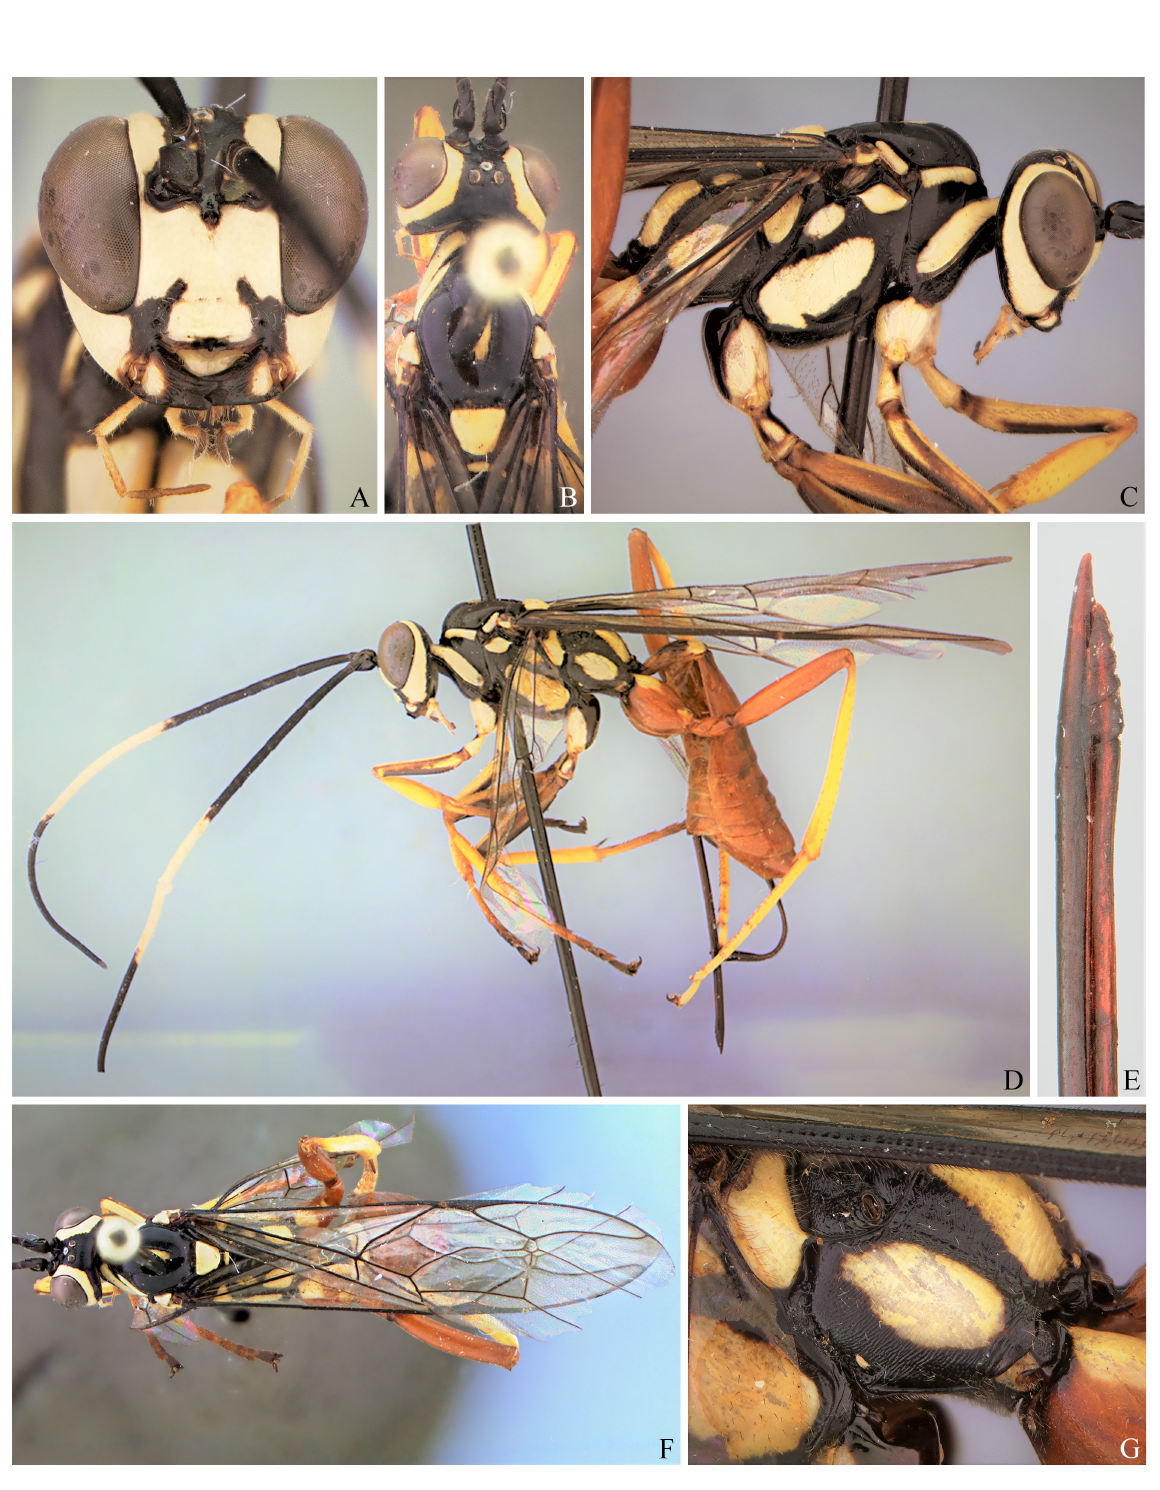
Fig. 12. Distictus notabilis sp. nov., holotype (AMNH), ♀. A . Head, frontal view. B . Head + mesosoma, dorsal view. C . Head + mesosoma, right side. D . Habitus. E . Apex of ovipositor, left side. F . Dorsal view. G . Propodeum and metapleuron, left